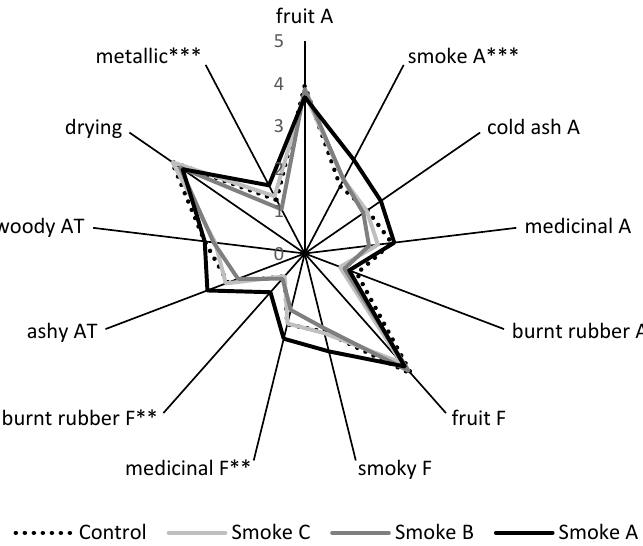
Figure 5. Sensory profiles of control and smoke-affected Cabernet Sauvignon wines; A = aroma, F = flavor, AT = aftertaste. Data are the mean intensity ratings for one blended wine per treatment, presented to 52 panelists; ratings for starred attributes were statistically significant (*** = p ≤ 0.05; ** = p ≤ 0.01; two-way ANOVA).